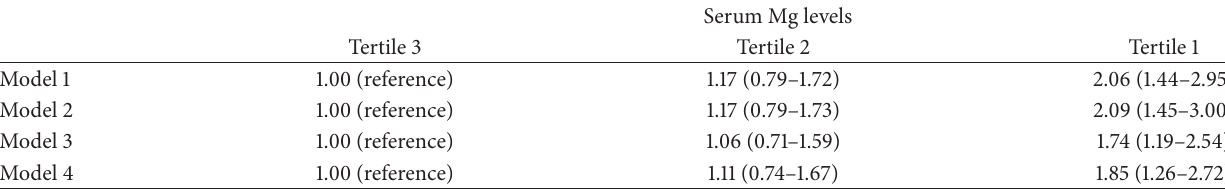
Table 2: Association between serum Mg levels and the prevalence of microalbuminuria.